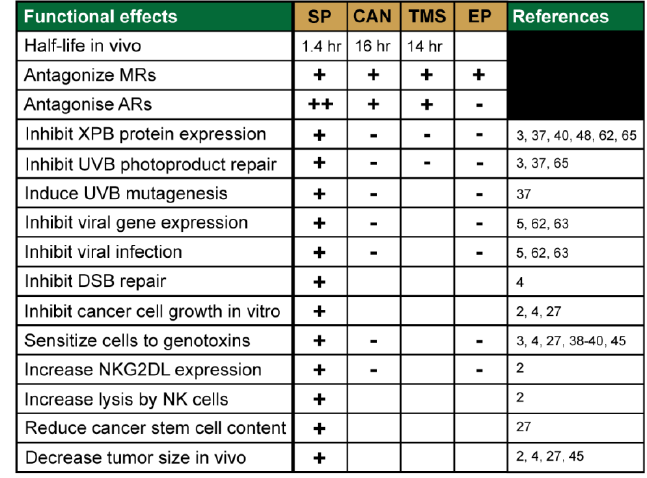
Figure 4. Specific functional e ff ects of spironolactone. The table provides an overview of the di ff erent e ff ects that spironolactone, its metabolites, and the related compound eplerenone have been demonstrated to have in di ff erent in vitro and in vivo biological